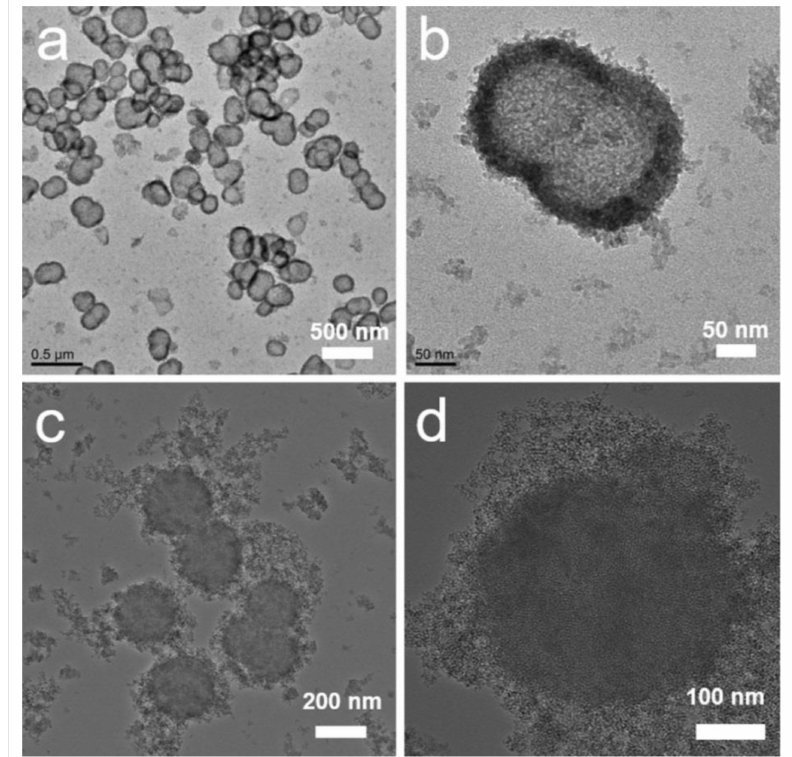
Figure 1. TEM images of the amino-functionalized mesoporous silica synthesized under different CO 2 pressures: ( a , b ) 1.0 MPa; ( c , d ) 0.2